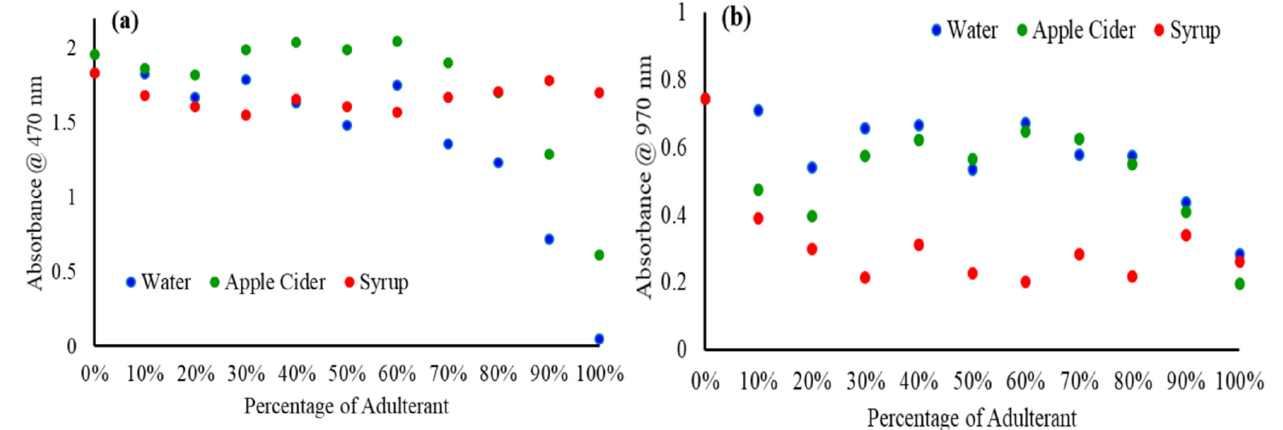
Figure 4. Relationship between the percentage of added adulterant and absorbance at ( a ) 470 nm and ( b ) 970 nm.